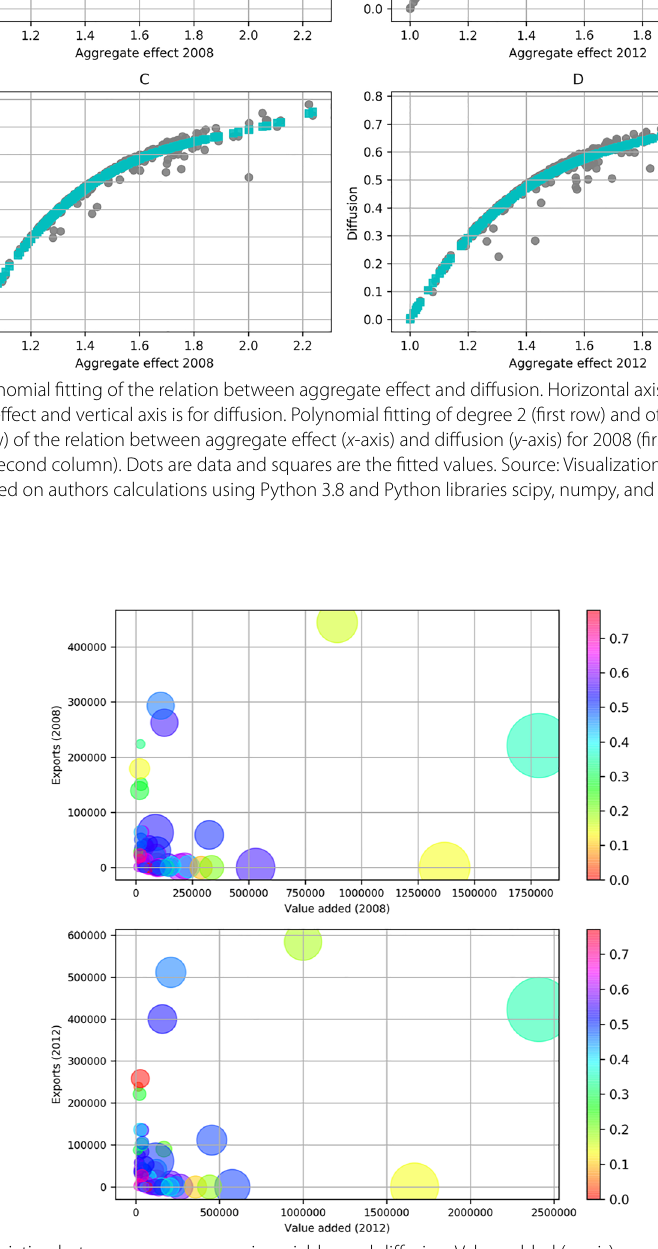
Fig. 3 Association between macroeconomic variables and diffusion. Value‑added ( x ‑axis), exports ( y ‑axis), production (size) and diffusion (color bar) for 2008 (up) and 2012 (down). This figure was generated by authors based on INEGI data using Python 3.8 and Python libraries scipy, numpy, and matplotlib.